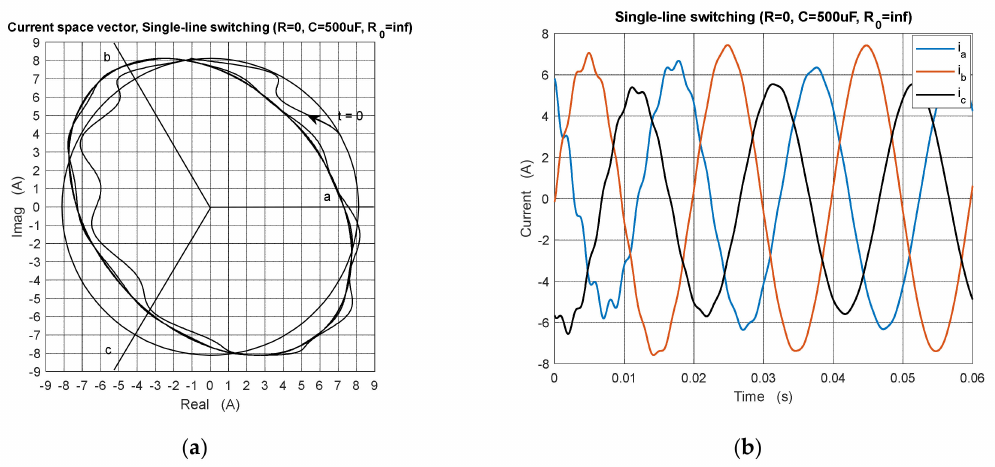
Figure 13. Single-line switching of phase a . Time-behavior of the current space vector ( a ) and the related phase currents ( b ) for the three-phase circuit in Figure 10 where S operates single-line switching of phase a with an impedance Z consisting of a capacitor C = 500 µ F. The single-phase circuit is open since R 0 → ∞ .